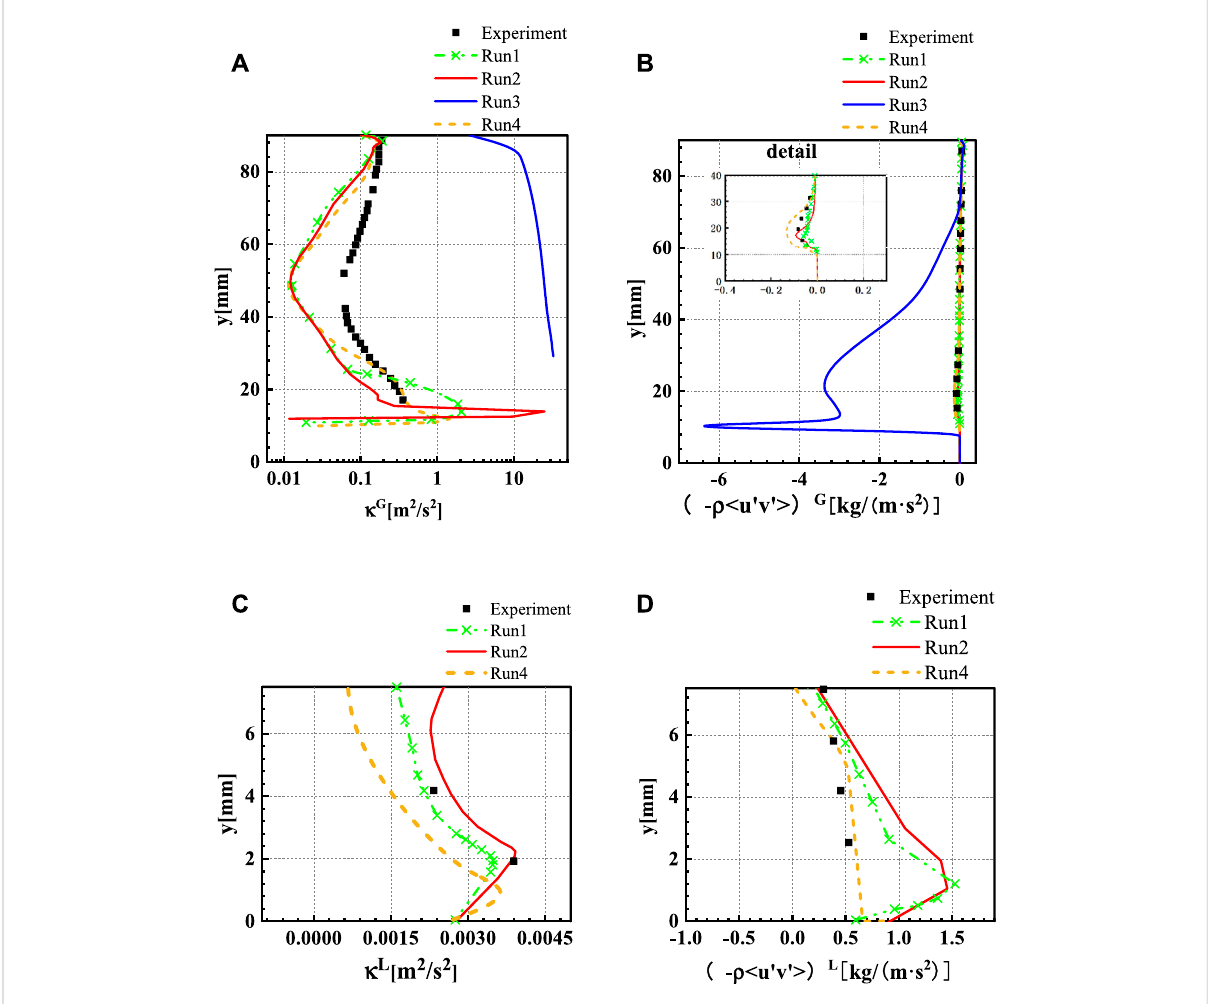
FIGURE 13 Turbulent kinetic energy ( κ ) and Reynolds stress component ( - ρ < u ’ v ’ > ) at MP1, (A) turbulent kinetic energy distribution of the gas phase, (B) Reynoldsstresscomponentdistributionofthegasphase, (C) turbulentkineticenergydistributionoftheliquidphase, (D) Reynoldsstresscomponent distribution of the liquid